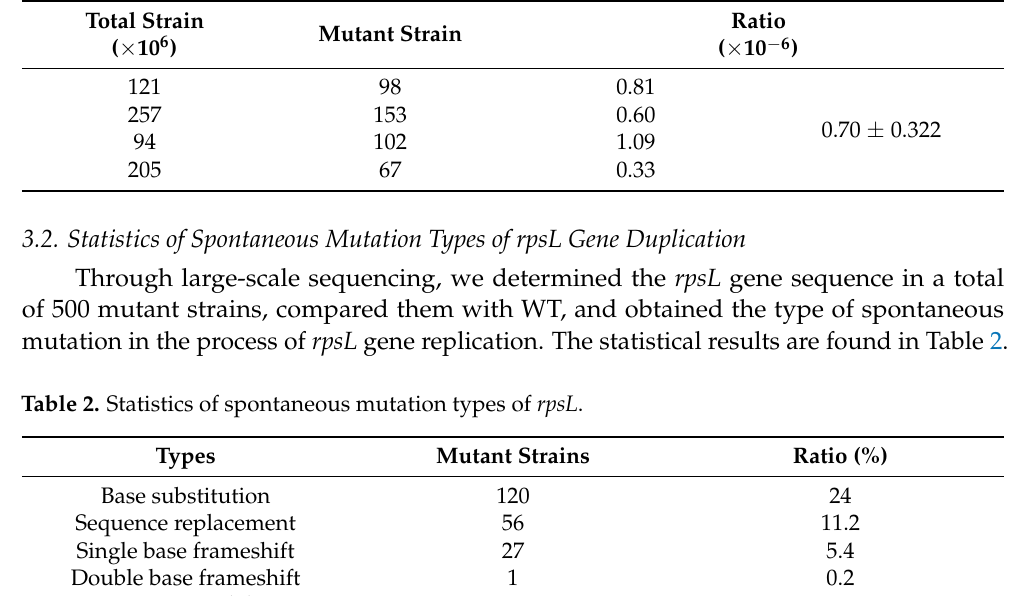
Table 1. Spontaneous mutation rate of rpsL .